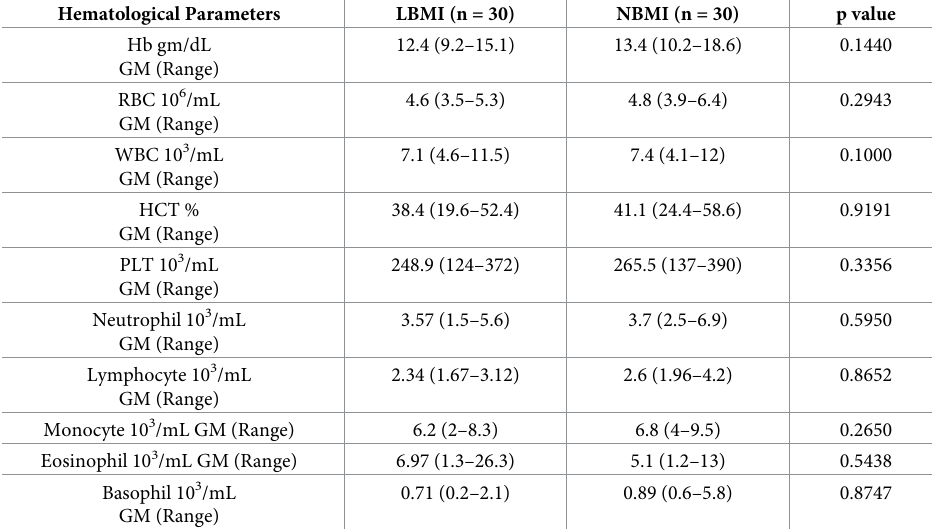
Table 2. Haematological parameters of the study population. Hematological